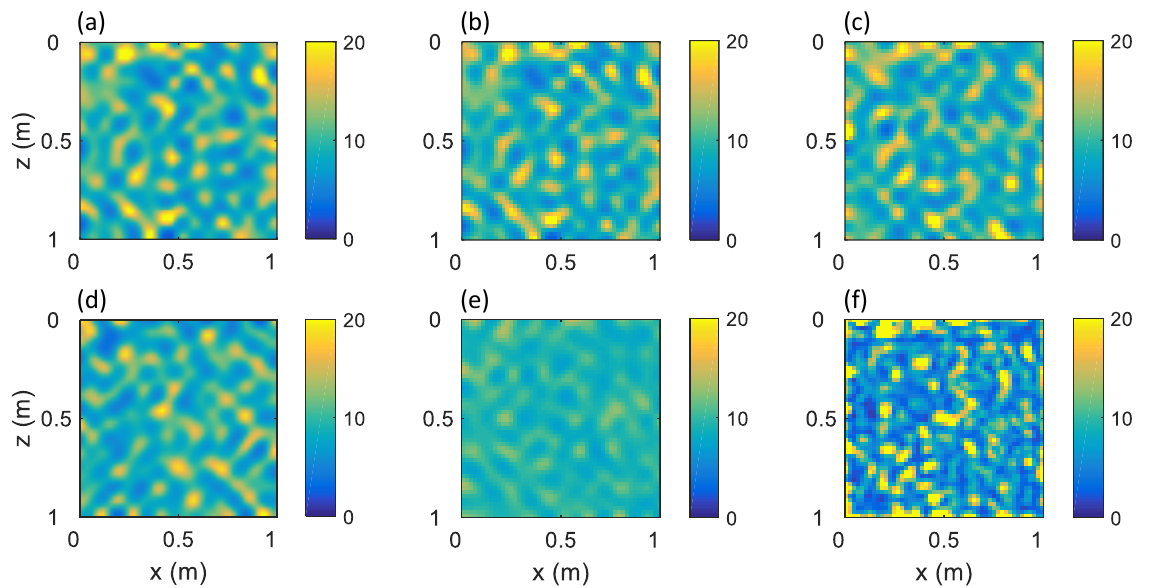
Figure 6. Posterior solutions using the FDTD model with first-arrival traveltime data: ( a – c ) three randomly selected realizations from the posterior distribution, ( d ) the maximum a-posteriori (MAP) density solution, ( e ) the posterior mean realization, and ( f ) variance of the posterior solutions.